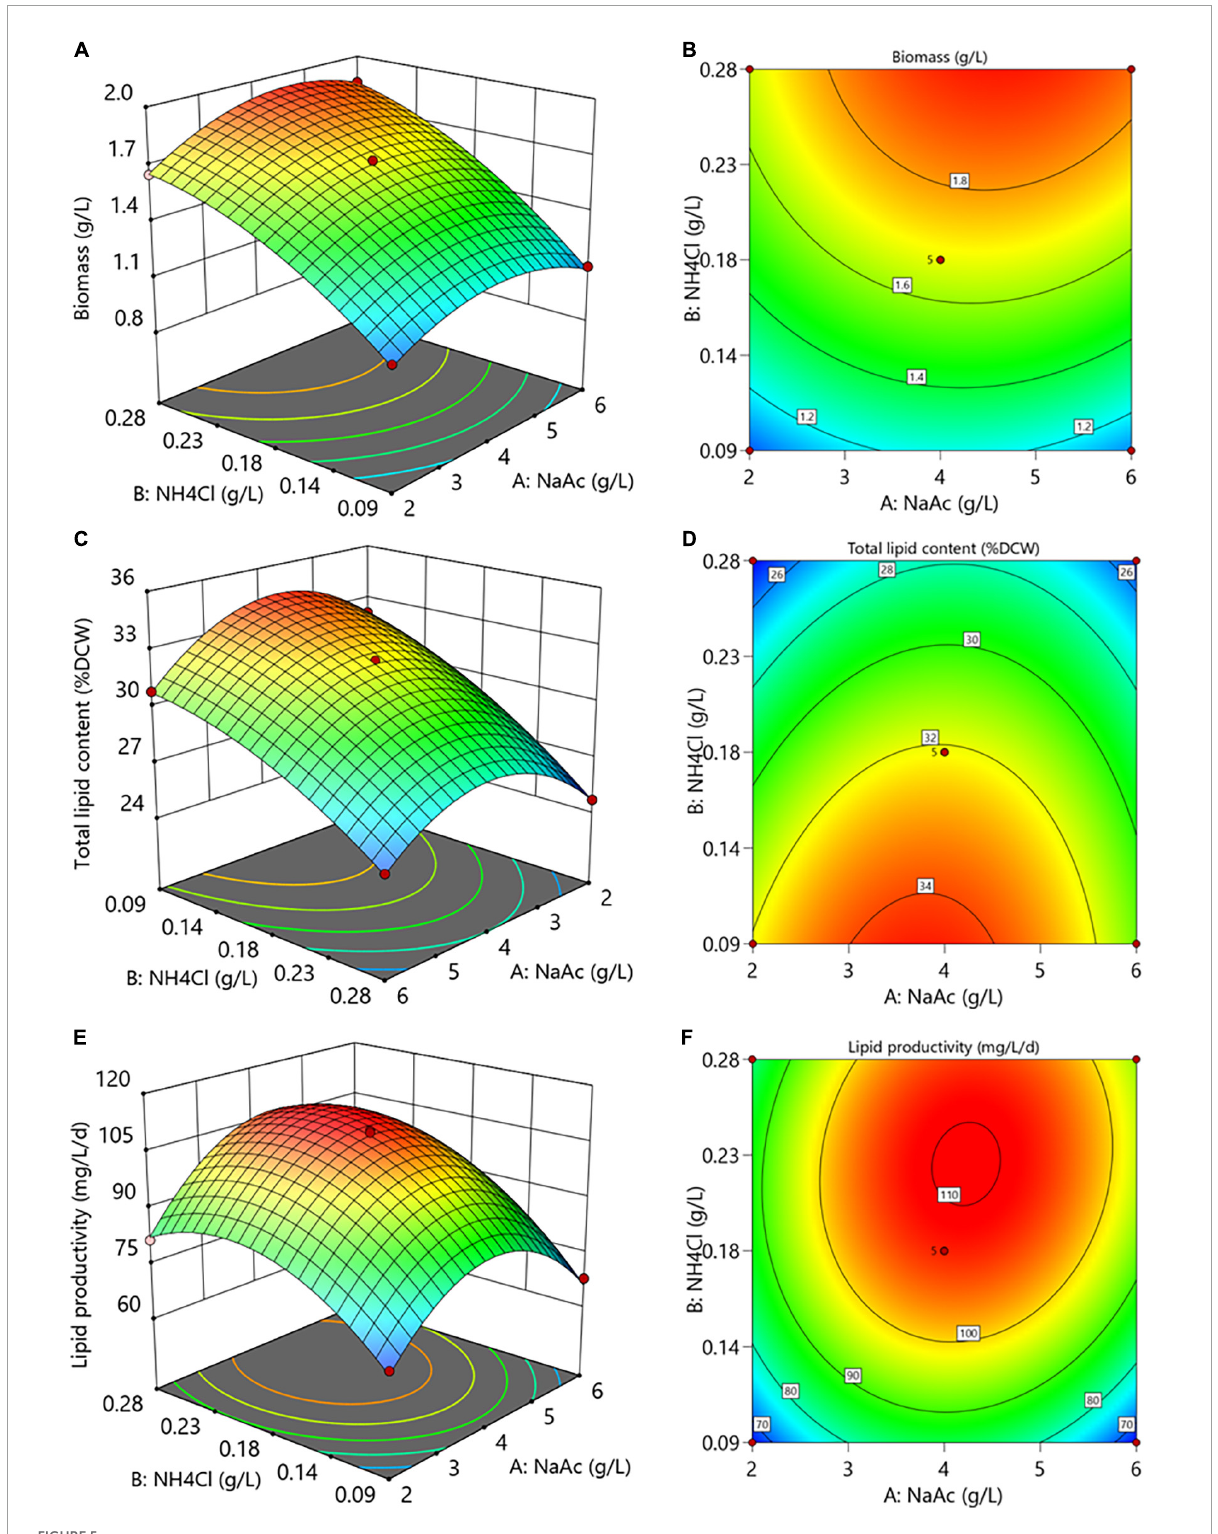
FIGURE5 The 3D surface and contour plots of the interactions of NaAc and NH 4 Cl on the biomass (A,B) , total lipid content (C,D) and lipid productivity (E,F) of C. reinhardtii